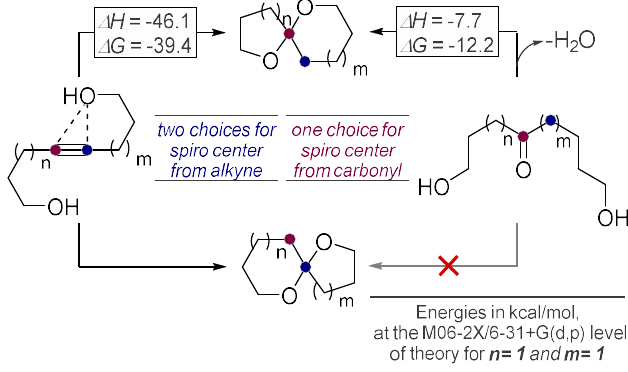
Scheme 7. Comparison of alkynes and ketones in intramolecular spiro-ketalizations.